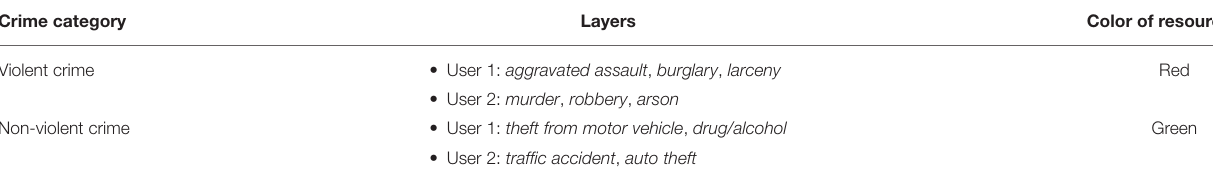
TABLE 1 | Type of crime, associated crime layers in the testbed per user, and corresponding color of resource pin.